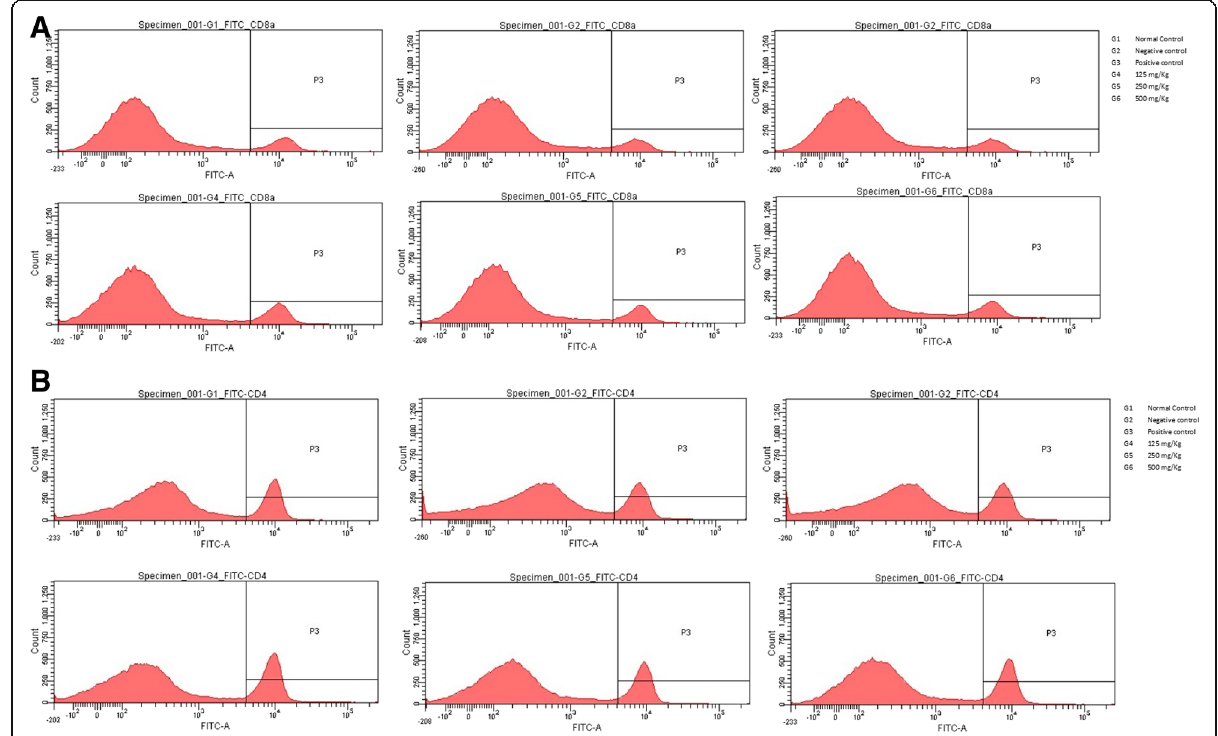
Fig. 3 FITC-conjugated CD8a ( a ) and PE-conjugated CD3 ( b ) T cell population comparison among different treatment